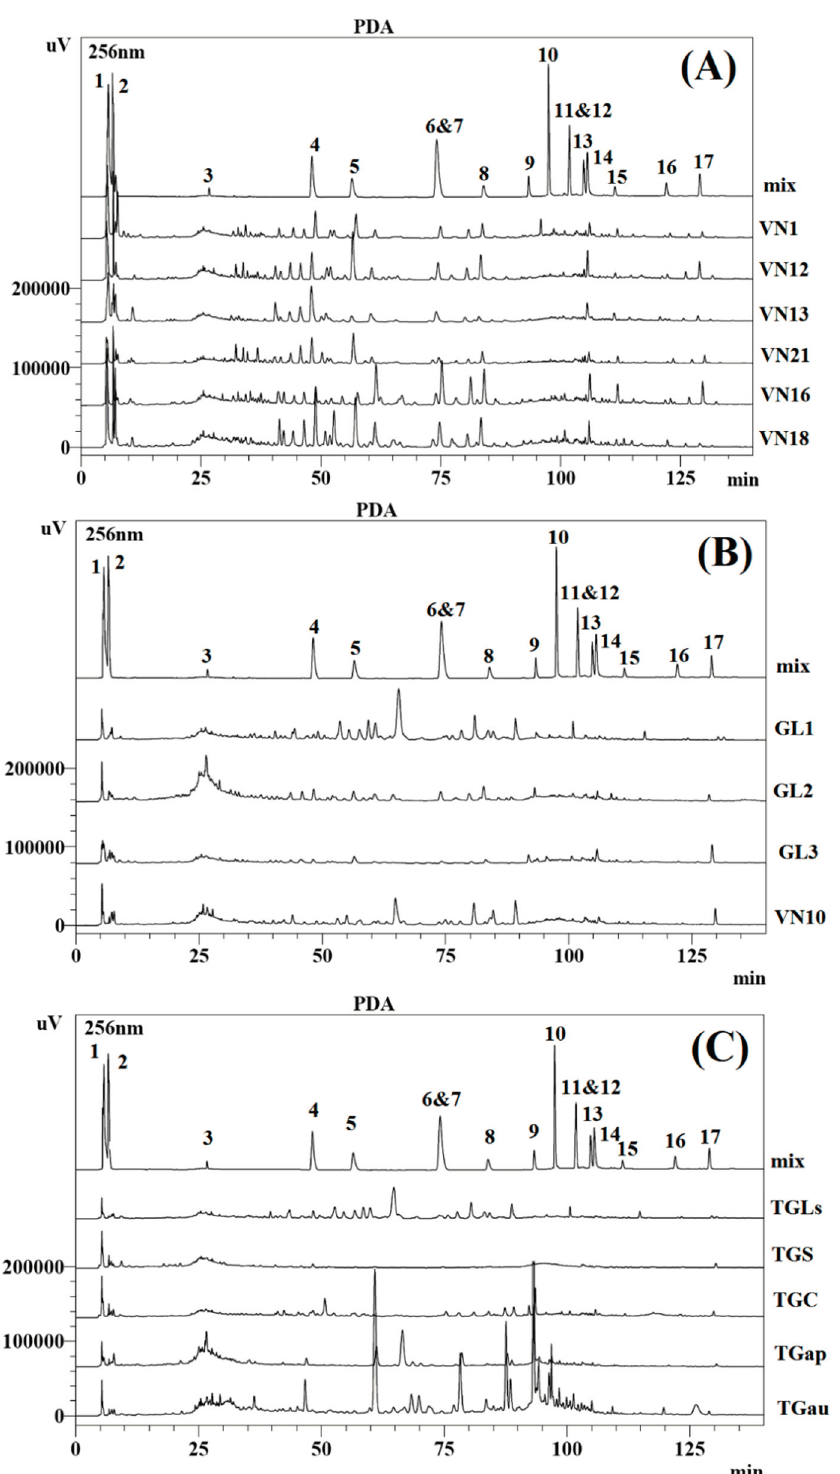
Figure 2. Chromatographic fingerprints of Ganoderma species. ( A ) the wild collected Linhzhi group ( Group A ); ( B ) the cultivated Linhzhi group ( Group B ); ( C ) the related Linhzhi species group ( Group C ). Compounds 1 – 17 were isolated from Ganoderma lucidum from the previous